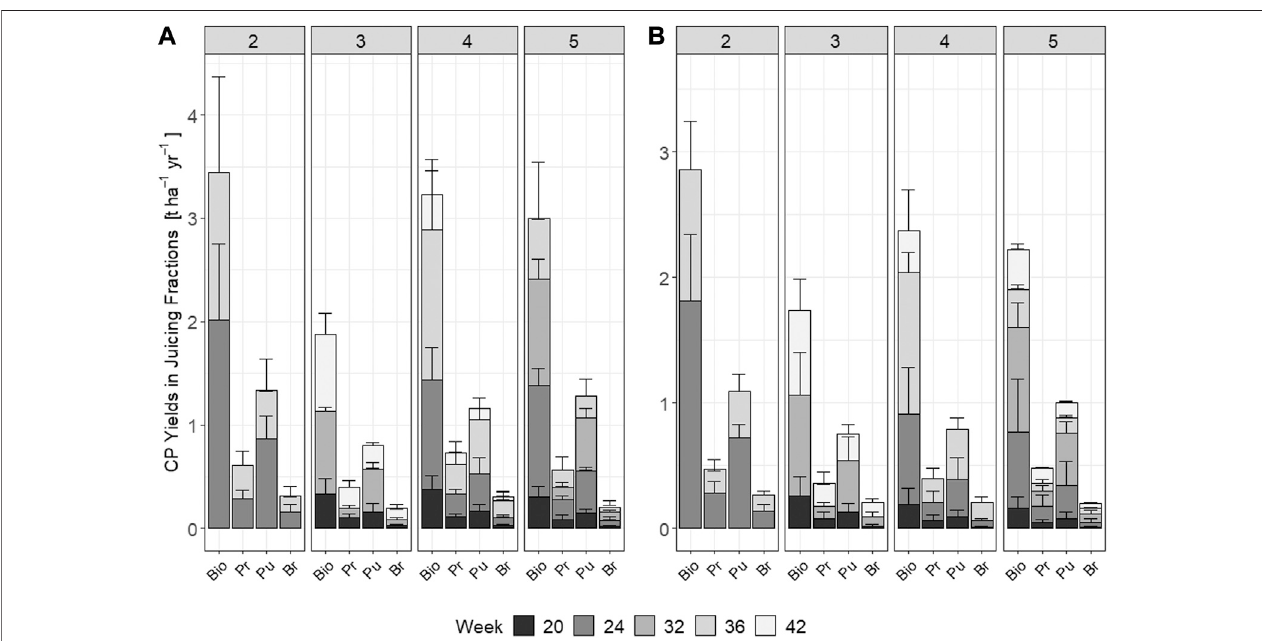
FIGURE 10 | Total annual yields (t ha − 1 year − 1 ) and yields (t ha − 1 ) for individual harvest weeks of crude protein (CP) in the biomass and in the screw-pressed fractions forthe various treatments and species (A) reed canary grass (left-hand panel), and (B) tall fescue (right-hand panel).Abbreviations:Bio (cid:2) Biomass,Pr (cid:2) Protein Paste, Pu (cid:2) Pulp, Br (cid:2) Brownjuice. Error-bars show standard